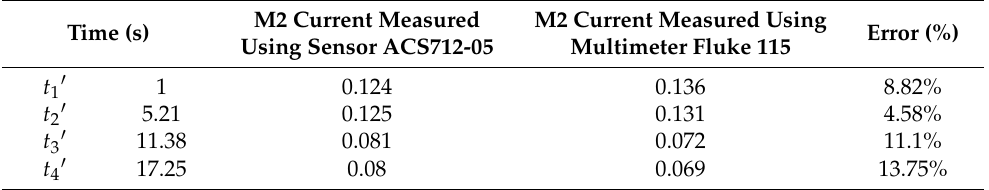
Table 7. Values obtained experimentally with the current sensor and the multimeter for motor M2.